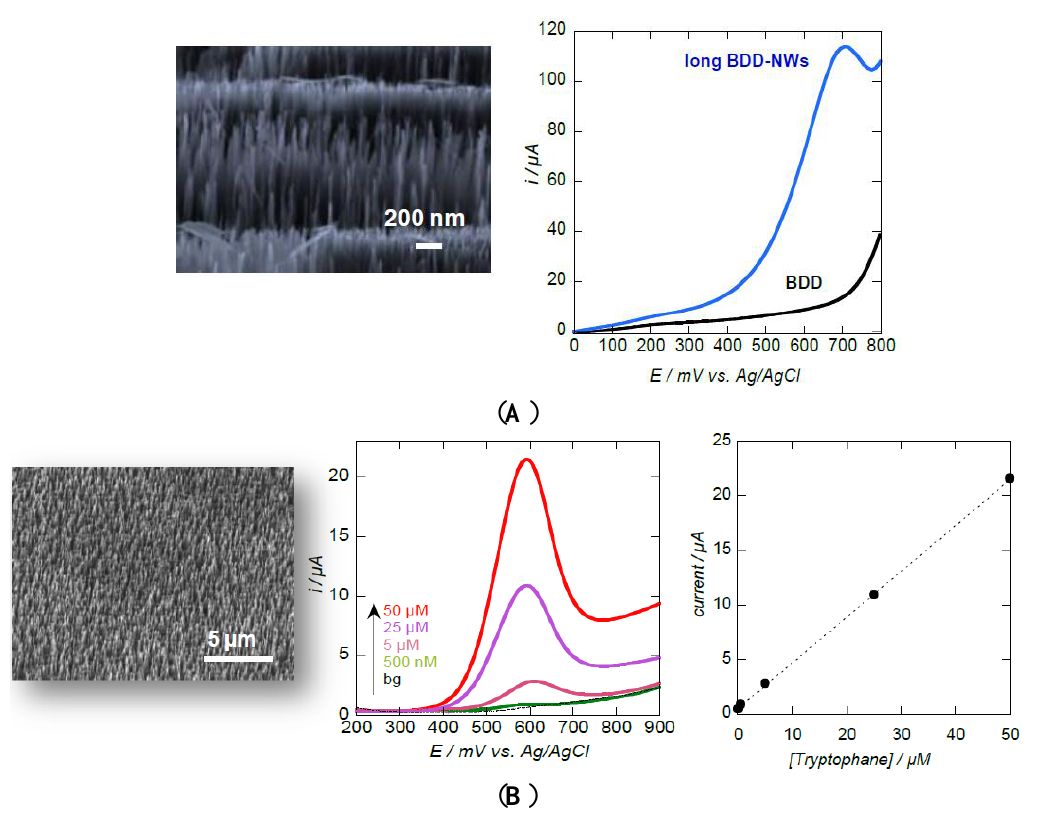
Figure 9. Diamond nanowires for enzyme-free glucose and tryptophan sensing: ( A ) SEM image of long diamond nanowires produced through mask-less RIE of CVD diamond films and linear sweep voltammogram recorded in 2 mM glucose solution (0.1 M NaOH) for BDD (black) and long BDD NWs (blue) (reprint with permission from [12]); ( B ) SEM image of short diamond nanowires together with differential pulse voltammograms for different concentrations of tryptophan and the corresponding calibration curve (reprint with permission from